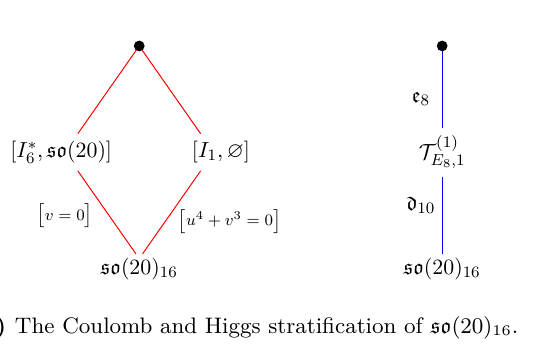
Figure 1. Information about the so (20) 16